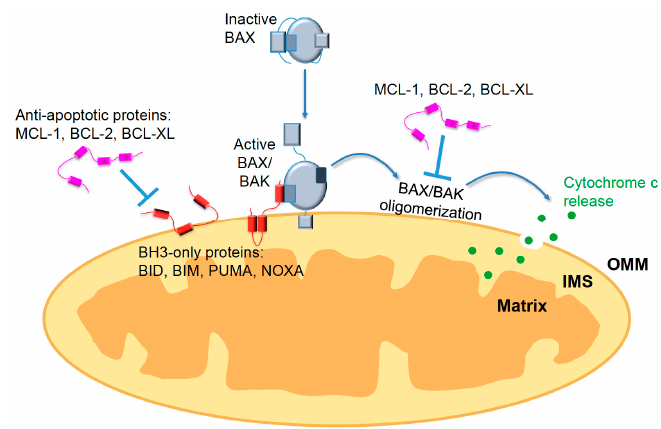
Figure 3. The BCL-2 family of proteins regulate mitochondrial-mediated apoptosis. After apoptotic stimuli, BH3-only proteins activate BCL-2-associated X protein (BAX) and Bcl-2 homologous antagonist/killer (BAK), which undergo a conformational change and insert into the mitochondrial outer membrane (OMM). BAK/BAX oligomerize and form pores, releasing cytochrome c from the intermembrane space (IMS) into the cytosol. When cells are not undergoing apoptosis, the anti-apoptotic BCL-2 members prevent mitochondrial outer membrane permeabilization (MOMP) by sequestering the BH3-only proteins or by inhibiting BAK/BAX oligomerization (figure modified from Walensky L. and Gaviathotis E., 2011). BCL-XL: B-cell lymphoma extra-large; MCL-1: myeloid cell leukemia 1; BID: BH3 ‐ interacting domain death agonist; BIM: BCL ‐ 2 interacting mediator of cell